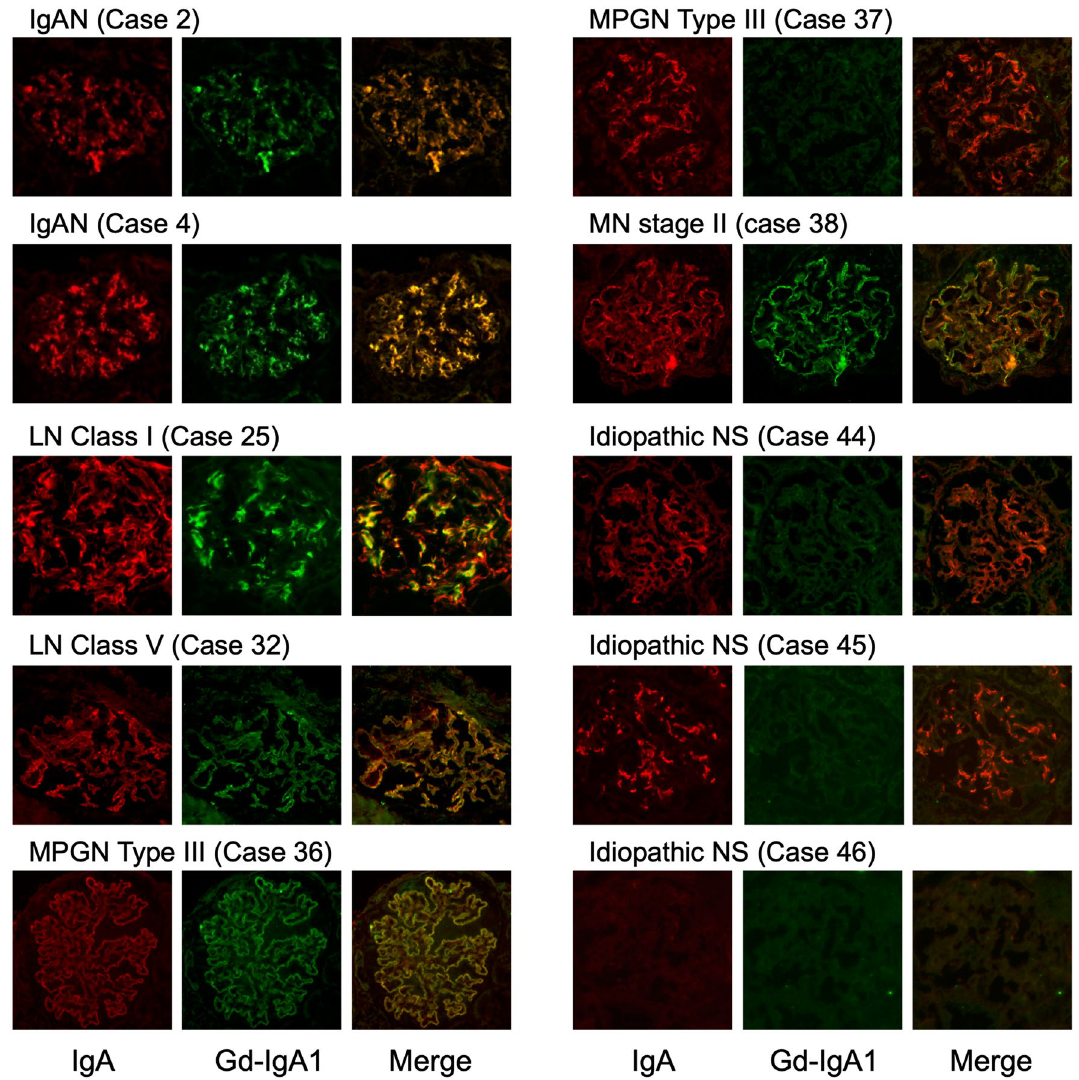
Figure 1. Double-immunofluorescence staining for IgA and Gd-IgA1. Double-immunofluorescence staining of frozen sections of biopsies from pediatric patients with glomerular diseases. First column, IgA